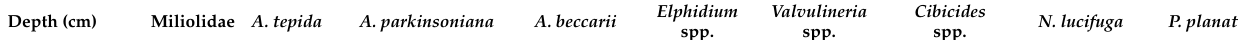
Table A9. Presence-absence data of benthic foraminifera taxa recorded at the studied cores. (black dots represent the presence of data of benthic foraminifera taxa recorded at the studied